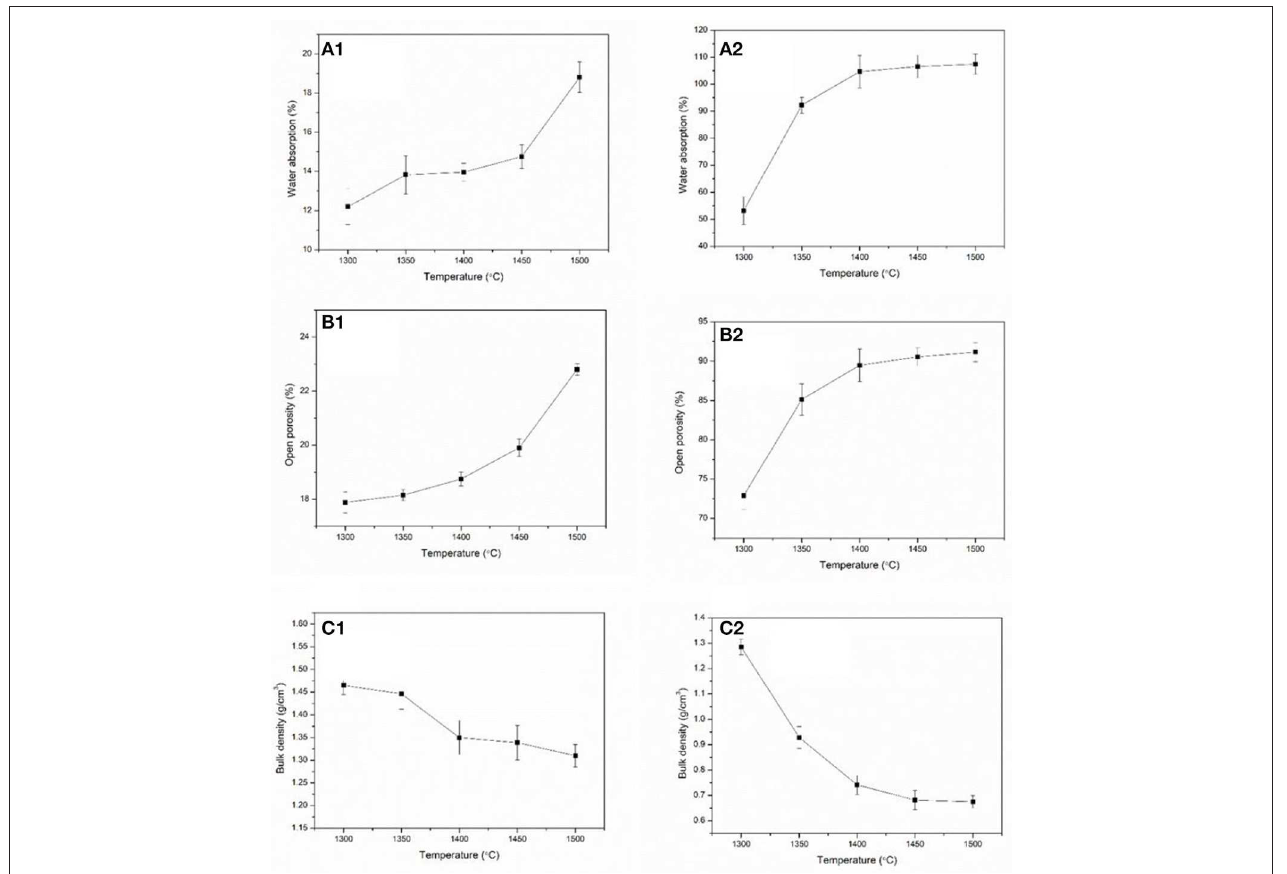
FIGURE 10 | Physical properties of green bodies and alumina ceramics: (A1) green bodies; (B1) green bodies; (C1) green bodies; (A2) alumina ceramics; (B2) alumina ceramics; (C2) alumina ceramics.